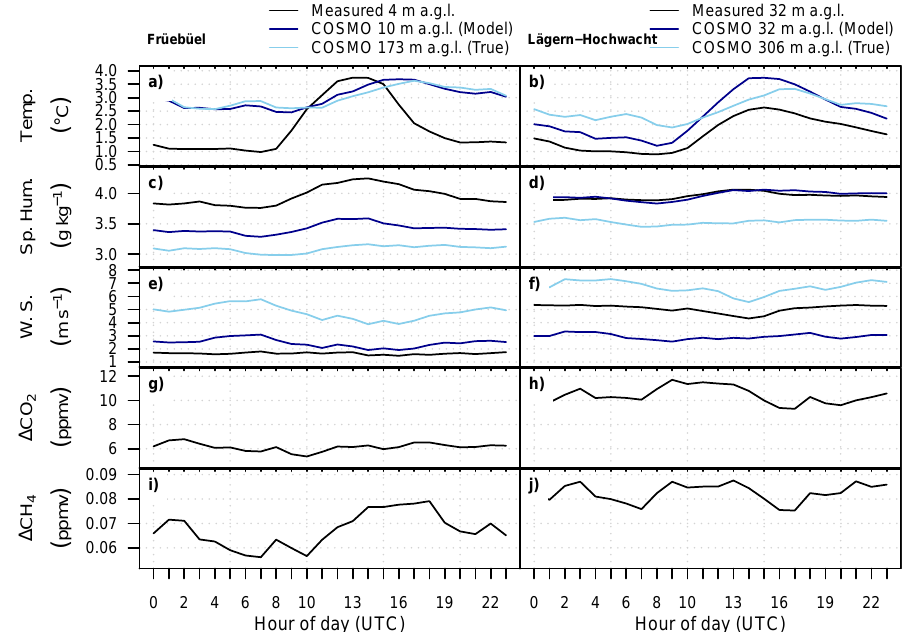
Figure 8. Similar to Fig. 5, mean diurnal cycles during winter (December 2013–February 2014) at the sites Früebüel and Lägern-Hochwacht. The Früebüel meteorological measurements were made at 2ma . g .